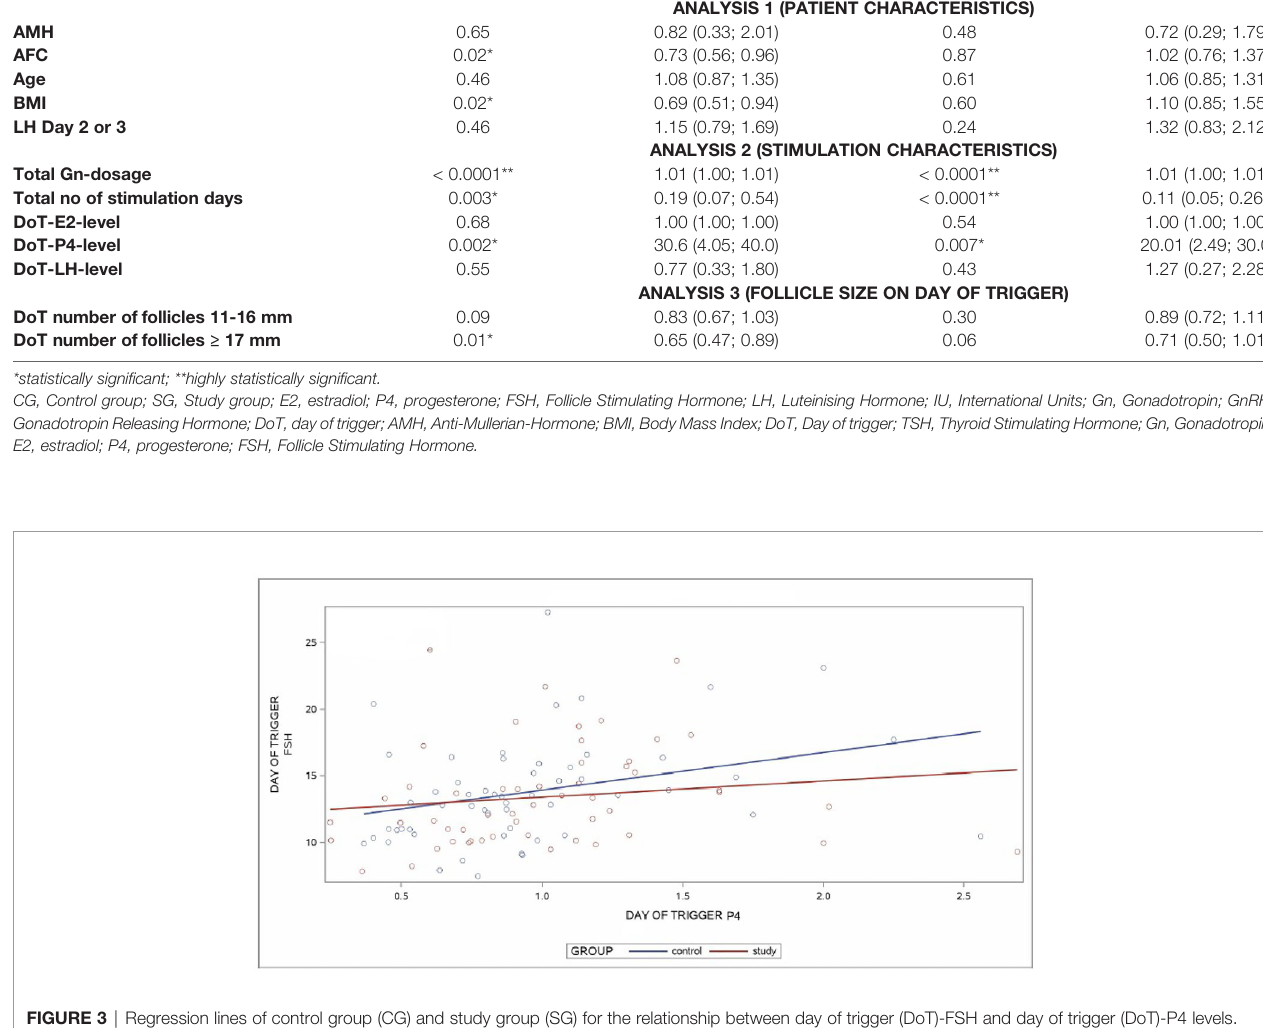
correlations between the serum FSH-levels on the day of fi nal oocyte maturation with the progesterone levels (CG: p = 0.001; SG: p = 0.0045) and a positive linear relationship between the serum FSH-DoT- and P4-DoT- levels in the CG (p = 0.0153), whereas no linear relationship was found between these parameters in the SG (p = 0.2939). These fi ndings con fi rm clearly the in fl uence of enhanced FSH-stimulation on the progesterone levels on the day of fi nal oocyte maturation.